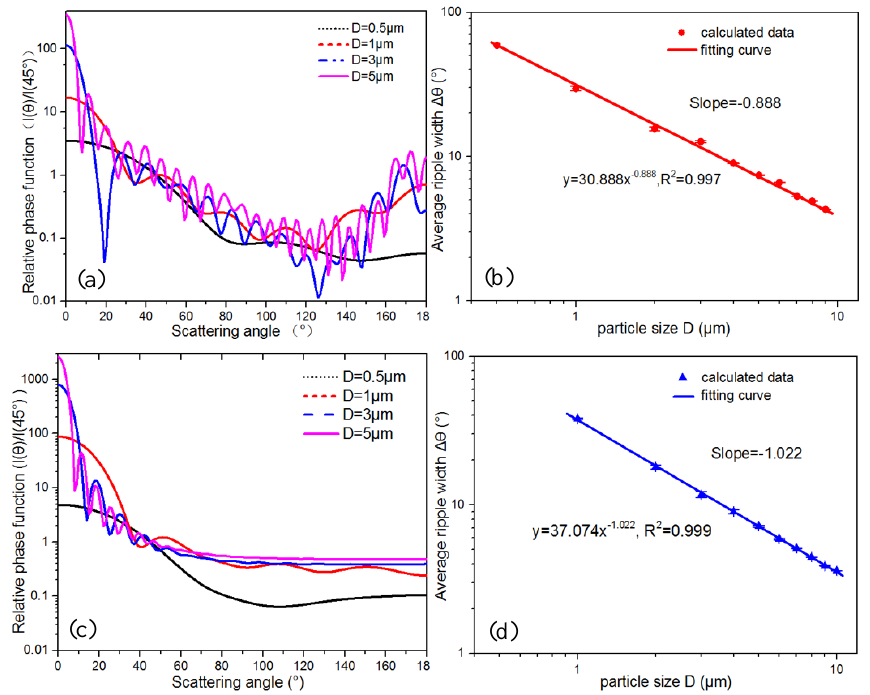
Figure 4. The relative phase function I ( θ ) / I (45 ◦ ) with di ff erent particle size and the relationship between average ripple width and the particle size are shown in the left and right panels, respectively, for ( a , b ) polystyrene particles and ( c , d ) coal dust.